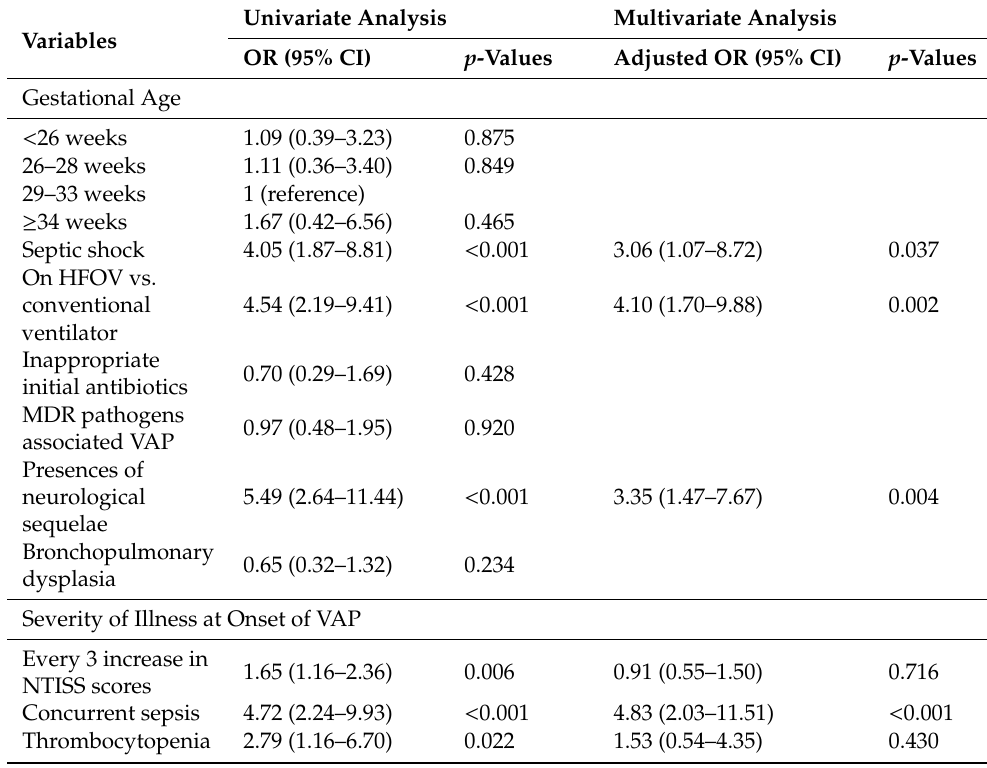
Table 4. Multivariate logistic regression analysis for independent risk factors of clinical treatment failure in neonatal ventilator-associated